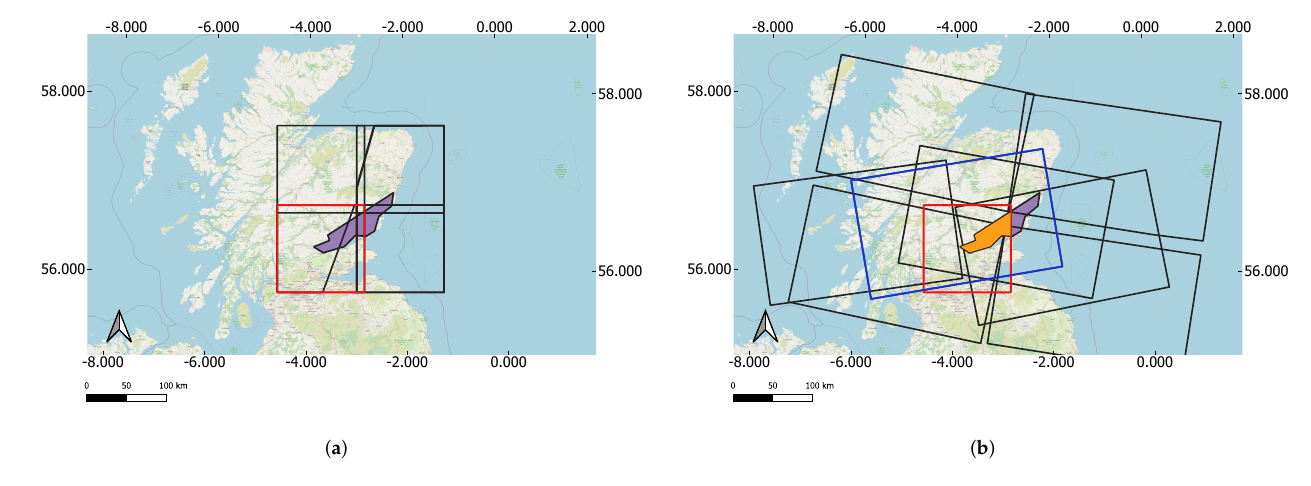
Figure 7. Example of selection of Sentinel-1 and Sentinel-2 products for the ROI shown in violet: ( a ) Selection of Sentinel-2 product shown in red from all the available overlapping Sentinel-2 products in black, ( b ) Selection of Sentinel-1 product shown in blue corresponding to the Sentinel-2 product selected in ( a ) from all the available overlapping Sentinel-1 products in black. The intersection of the ROI and Sentinel-2 is shown in orange. Base layer © OpenStreetMap contributors in EPSG:32630 UTM projection in Quantum Geographic Information System (QGIS) software. Table 1. Example of Sentinel-1 and Sentinel-2 product selection showing the overlap with the ROI selected in Figure 7.